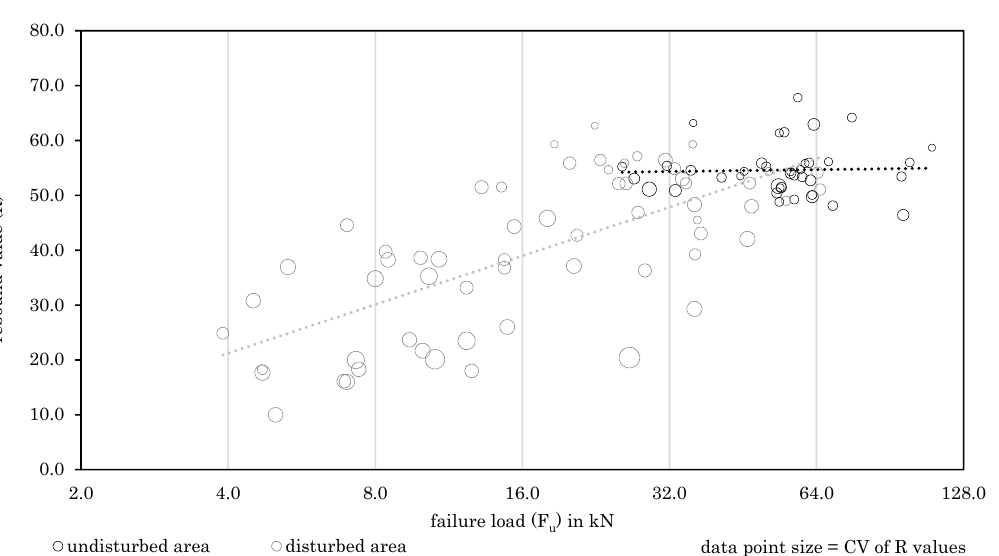
Figure 10. Relationship between rebound values and failure loads for all rock types. On the contrary, poor uniformly distributed rebound values can lead to a small scattering too. Small CVs therefore do not automatically indicate good fastening properties. Instead of that, they can originate from good or poor a priori rock properties. In Figure 11, the measured rebound values taken next to the anchor are shown using a radar chart. For both examples, the rebound values are evenly distributed. Although this results in similar CVs, the failure loads differ significantly. Therefore, using CVs to identify good rock properties is not sufficient. In order to prevent wrong conclusions being drawn from a low CV in regard to good rock properties, it is necessary to have a combined consideration of CV and mean R value.